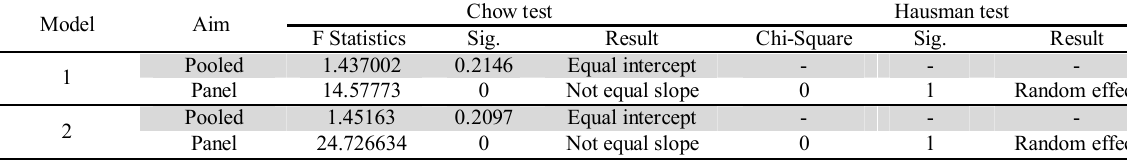
The results of Chow and Huasman tests